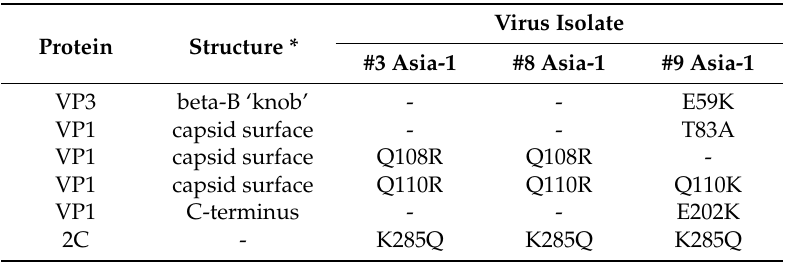
Figure 6. Capsid maps of the outer surface molecules of FMDV. The capsid map was created with VIPER [20] using FMDV O 1 /BFS/1860 and A 10 /Argentina/61 as templates: ( a ) overview of the exposed